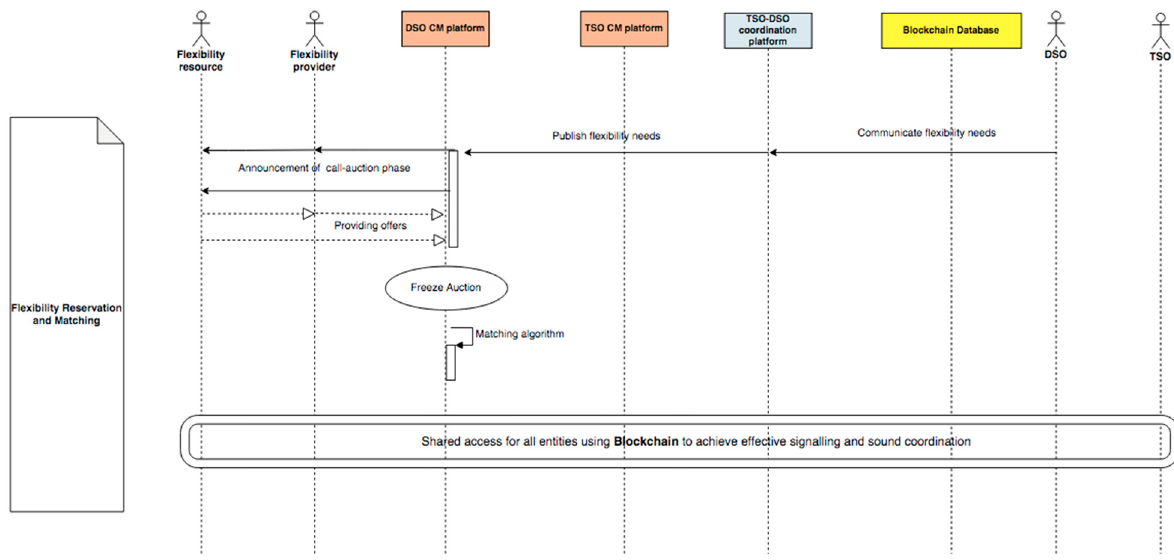
Figure 13. Flexibility reservation and matching.